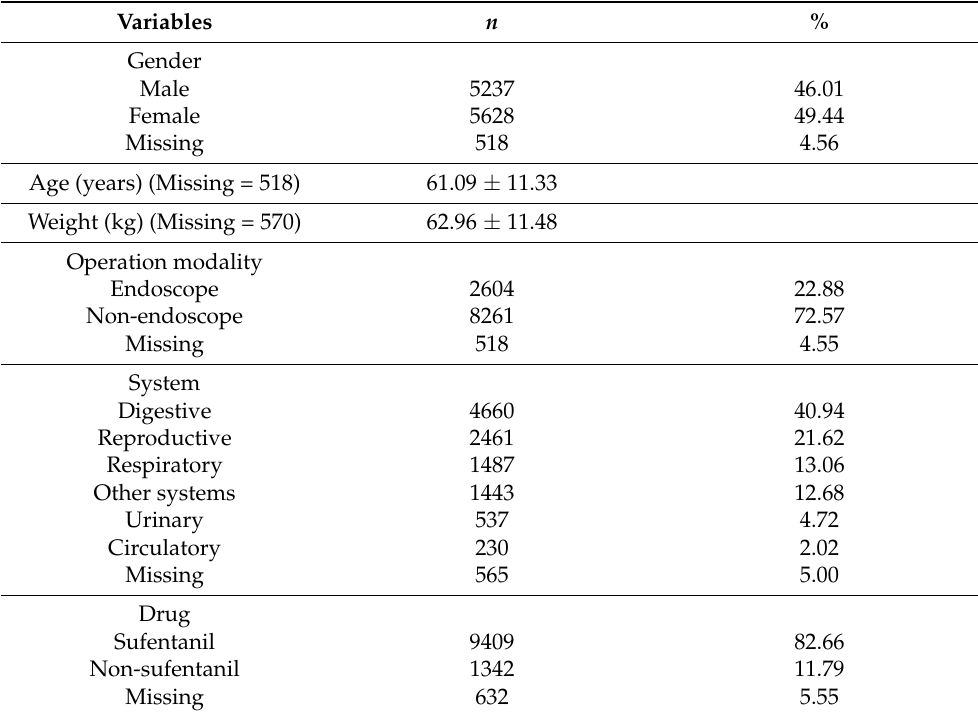
Table 1. Patients’ demographic data and surgical factors (N = 11,383).